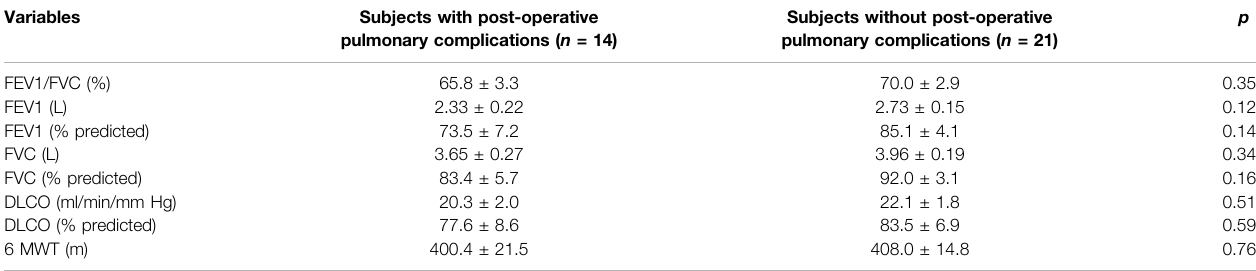
TABLE 2 | Pulmonary function and six-minute walk tests.